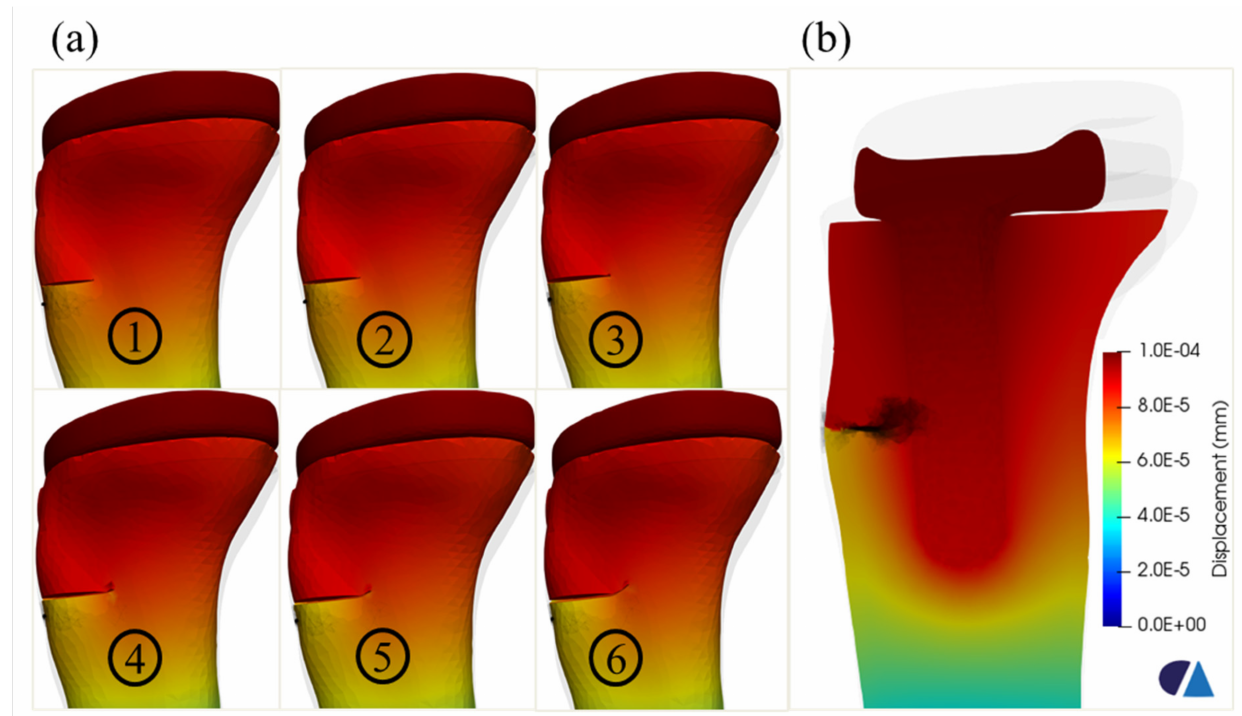
Figure 9. Crack propagation in the tibia model with implant—different steps ( a ) and a slicing surface along the implant in the last step ( b